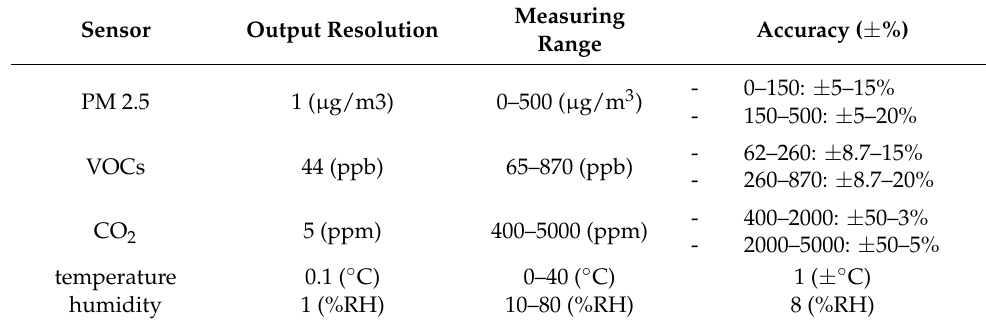
Table 2. Technical details about the sensors implemented by each monitoring